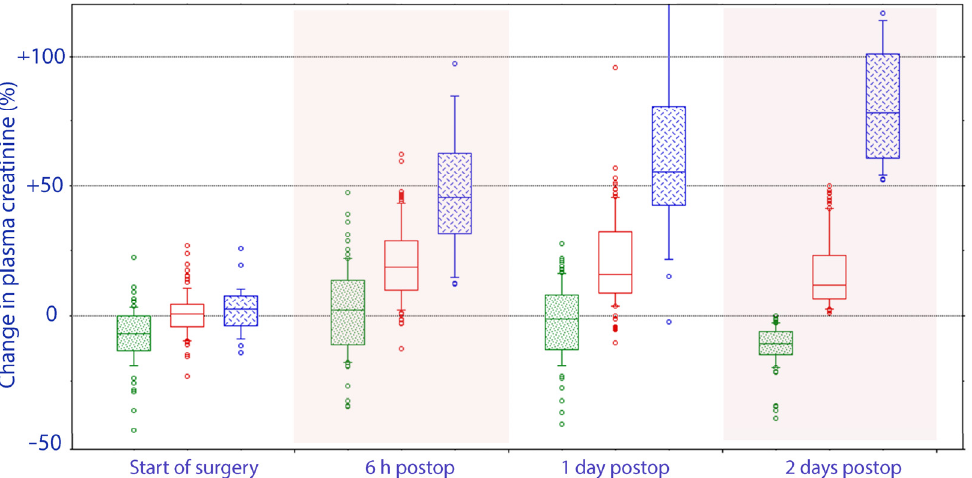
Figure 2. Perioperative trajectory of plasma creatinine based on whether the final postoperative value represented a decrease in plasma creatinine values (green), a moderate increase (0–50%; red) or a substantial increase (>50%, blue) as compared to the concentration measured on the day before surgery. A statistically significant difference between these groups had occurred already before surgery was initiated, i.e., from the day before the surgery to the onset of surgery.